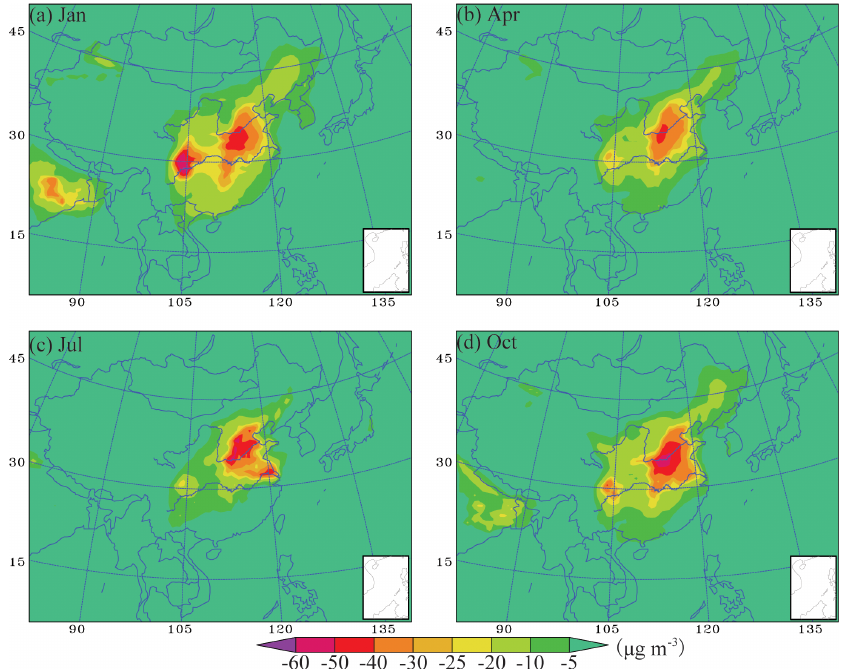
Figure 7. The horizontal distributions of SNA mass concentration (µgm − 3 ) variation associated with agriculture NH 3 removal in January, April, July, and